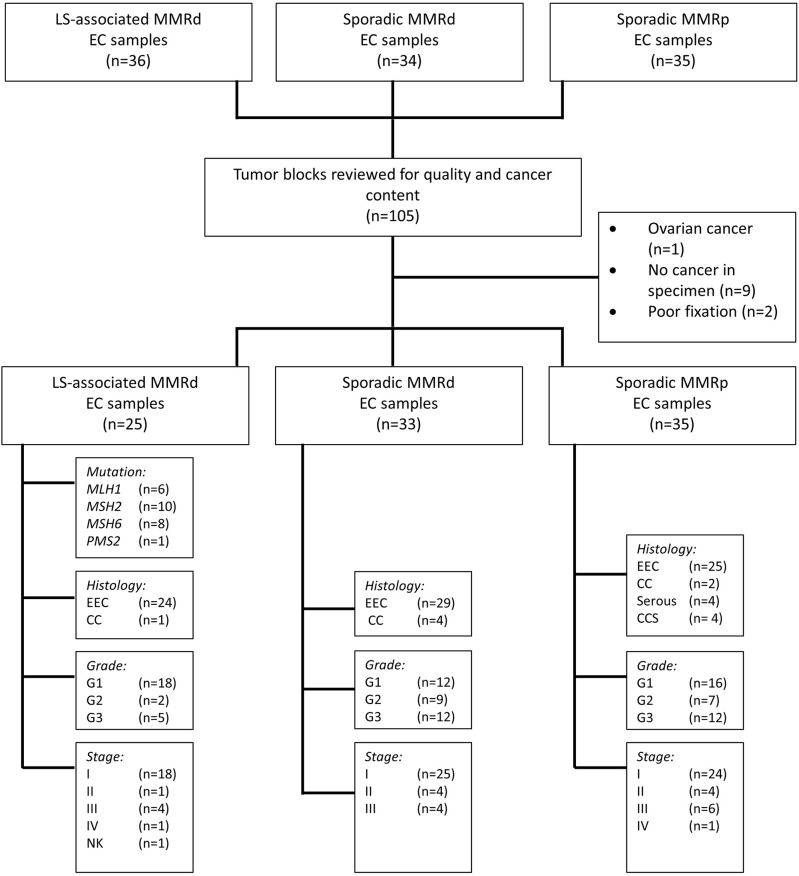
Study flow schema. EEC, Endometrioid Endometrial Cancer; CC, Clear Cell Endometrial Cancer; CCS, Carcinosarcoma of the uterus; G, Grade; NK, Not known; MMRd, mismatch repair deficient; MMRp, mismatch repair proficient.